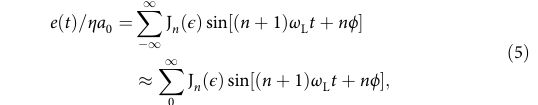
, E is parallel to the local surface. (2) Then in y 0 z plane E x 0 x 0